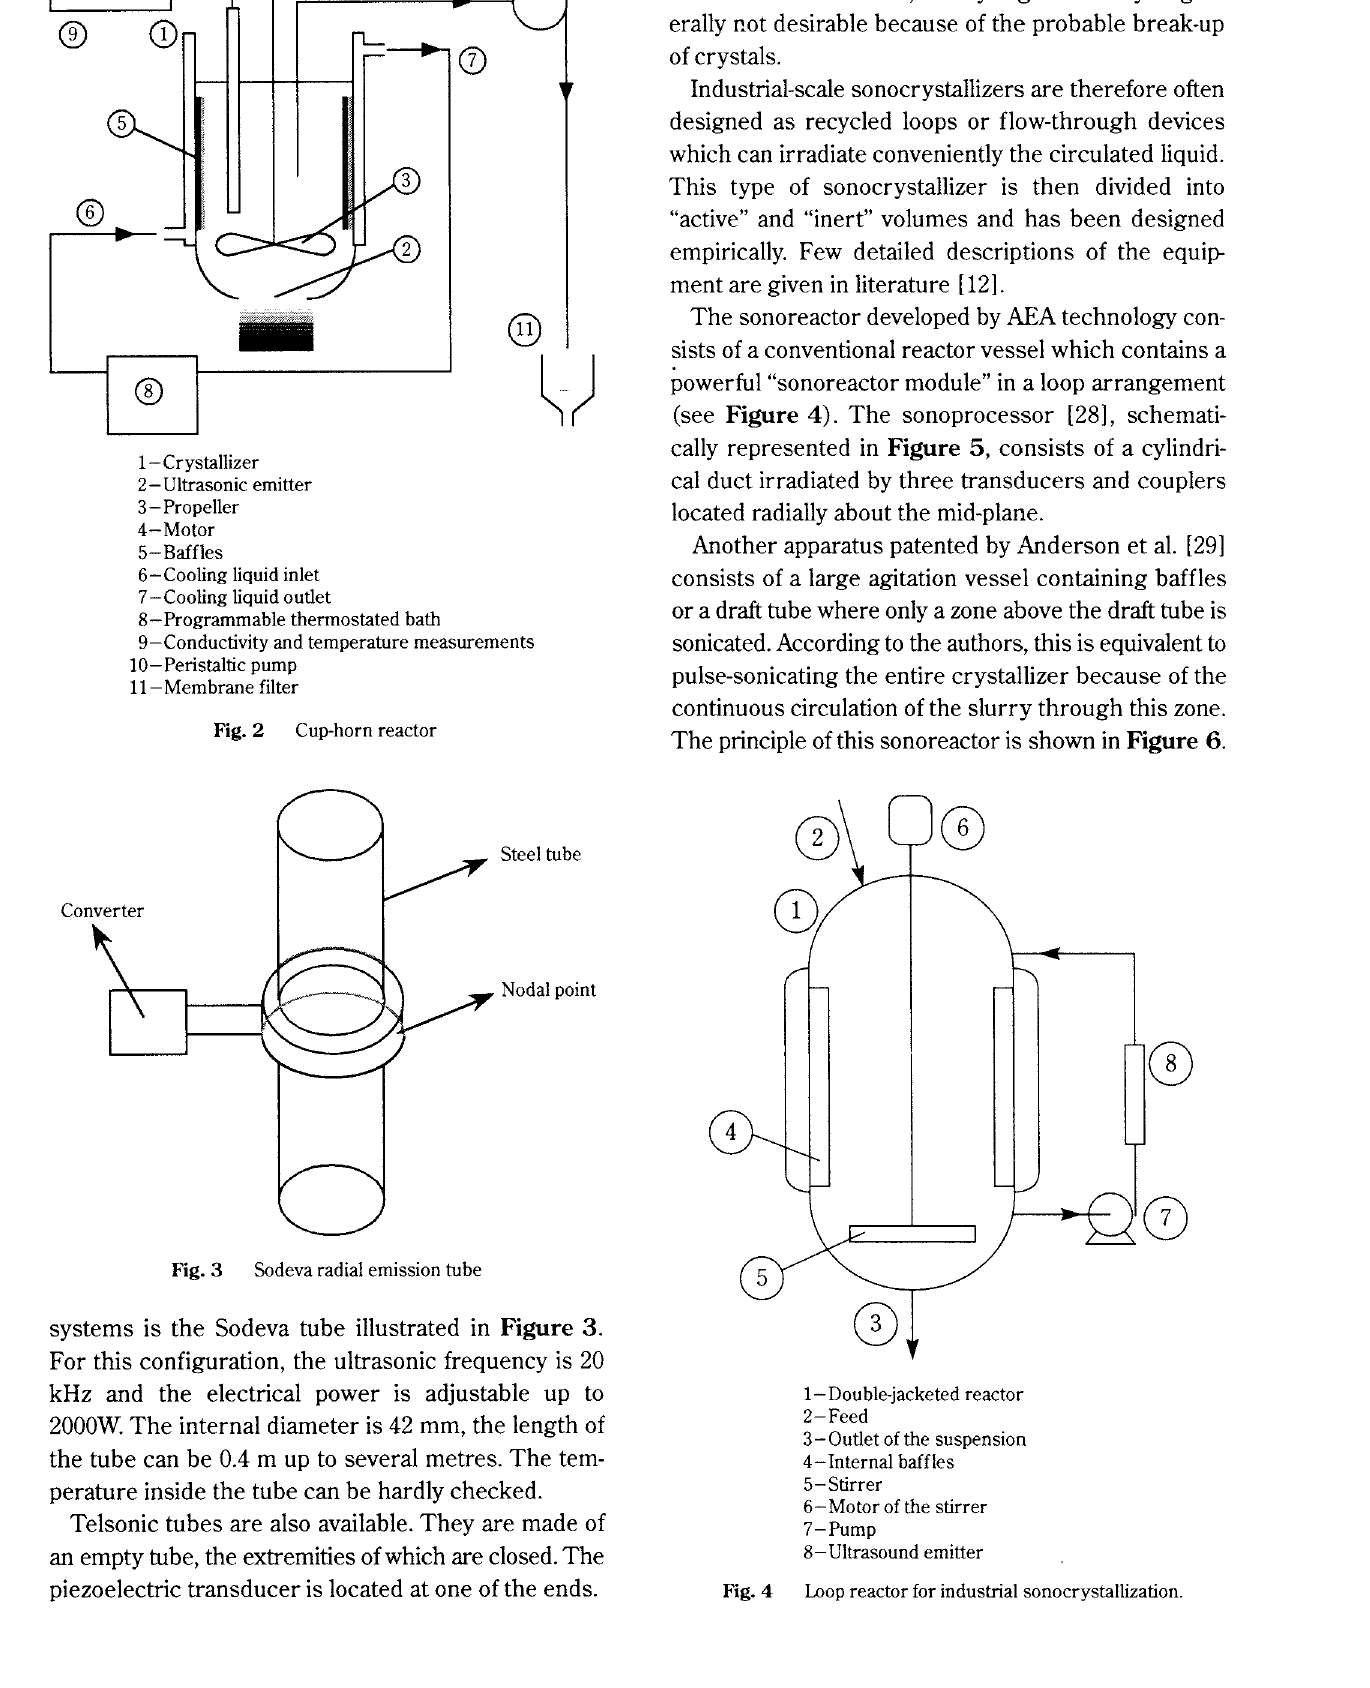
Loop reactor for industrial